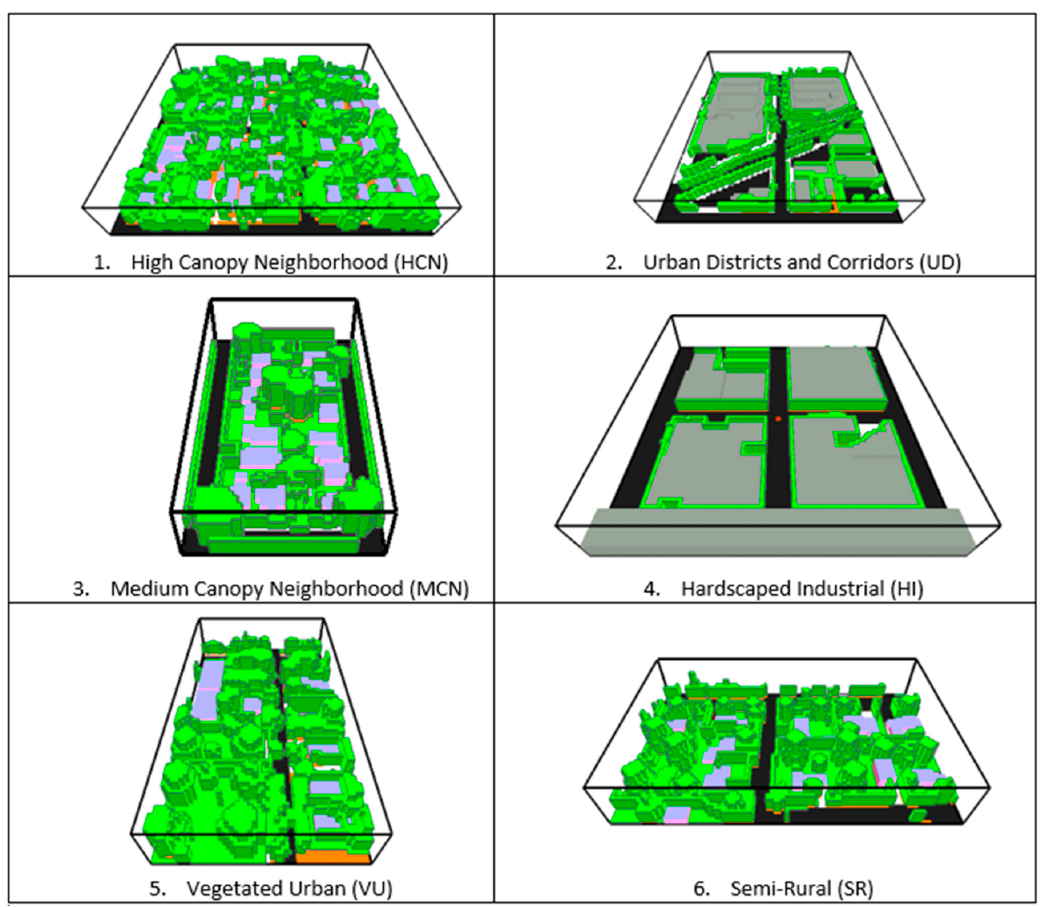
Figure 2. Input files for ENVI-met, representing the dominant land-use and / or land-cover types for each of the six selected study sites for “AddGreen” scenario.